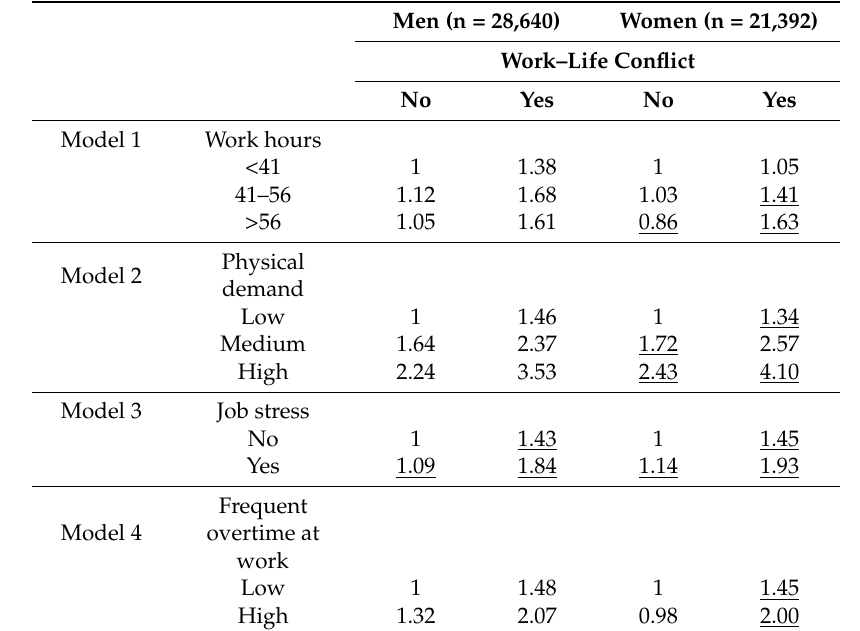
Table 3. Odds ratios for associations of musculoskeletal disorder and work–life conflict with key covariates with significant interaction